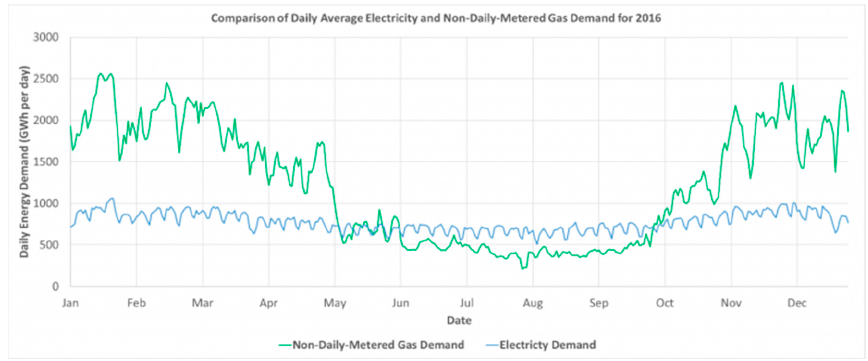
Figure 2 . Seasonal variation of the heat demand compared to the electrical demand [13]. Figure 2. Seasonal variation of the heat demand compared to the electrical demand